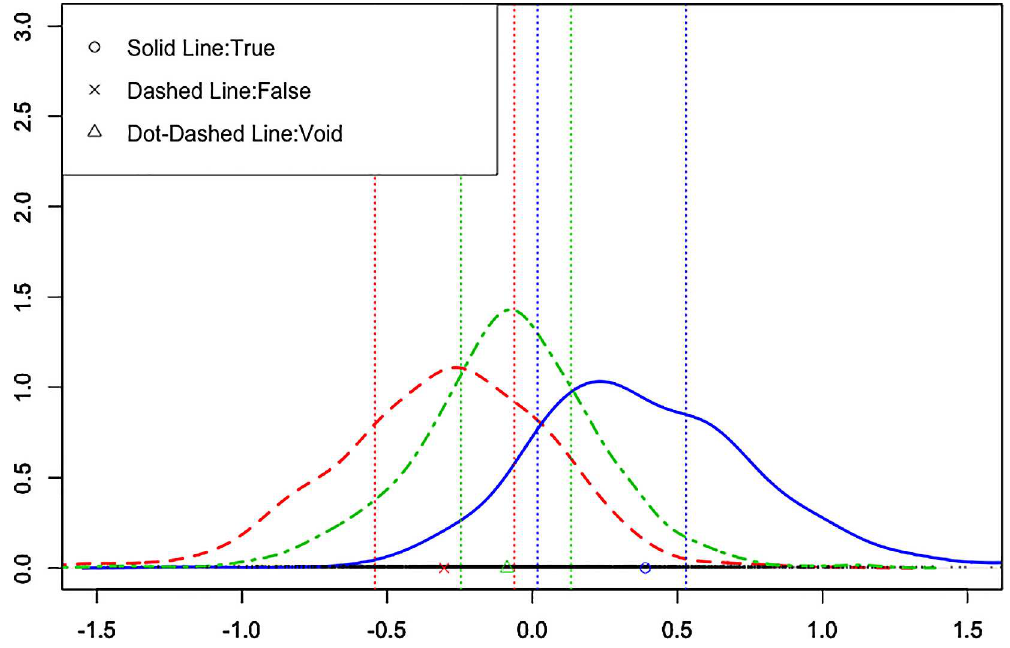
Fig 4. Density and Credible Intervals of 1000 Posterior Samples for the relevant fixed effectsof the Maximal Random Effect Structure for the Fixed Effects of the Suppositional * Matching Model. Vertical lines depict the 25–75%posterior